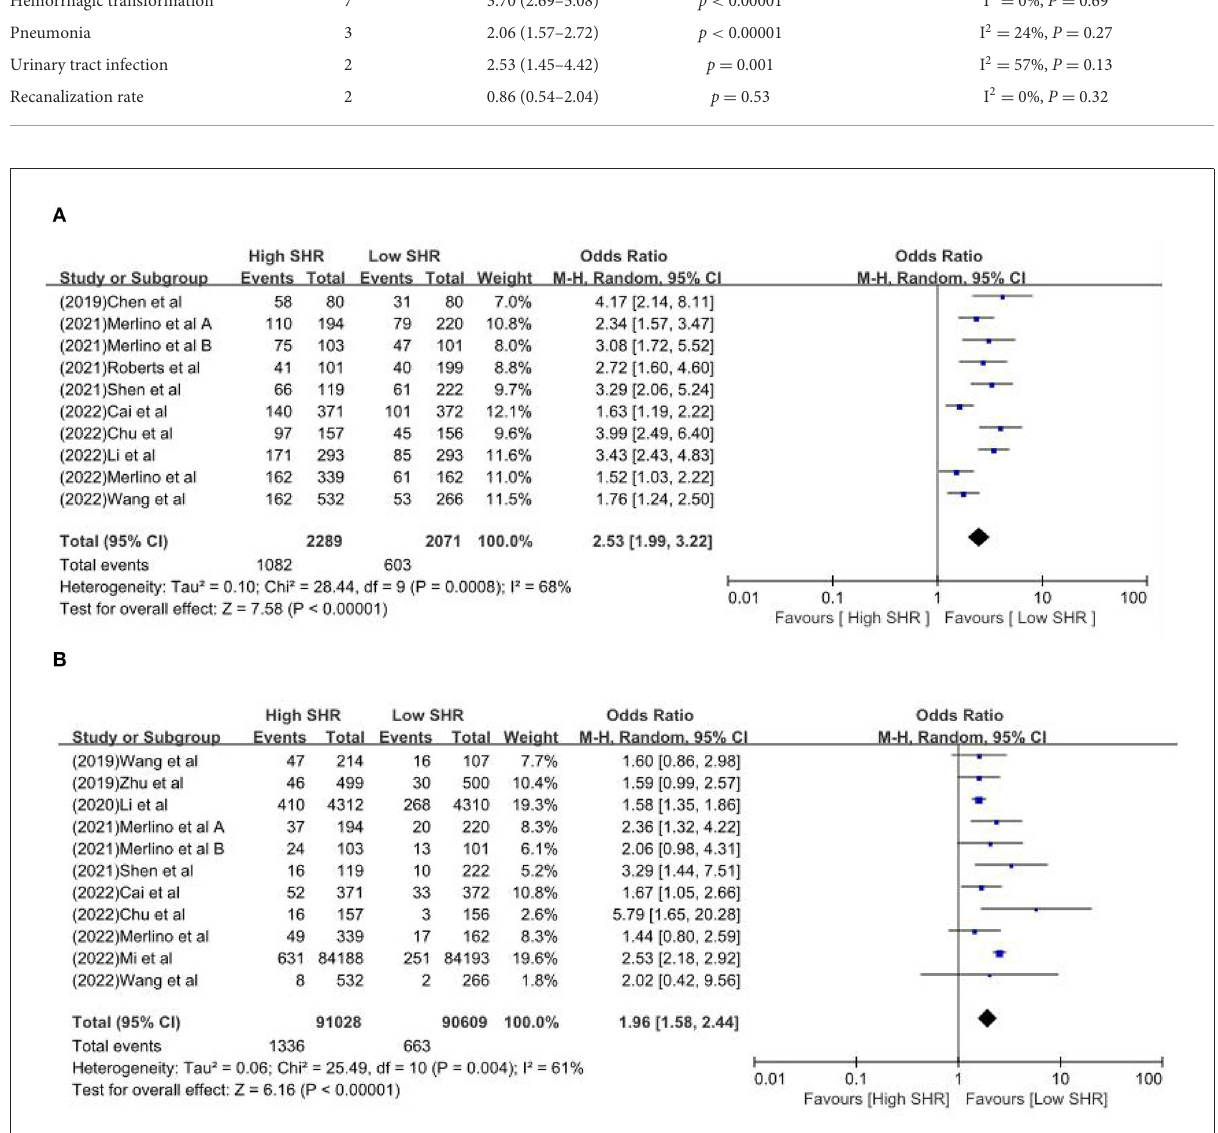
FIGURE2 The (A) Poor outcome and (B) Mortality between high SHR and low SHR groups.